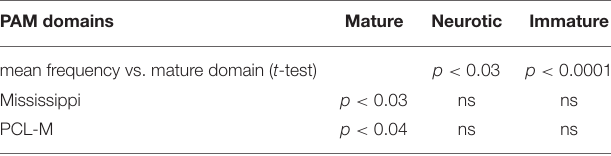
TABLE 2 | Mean difference and association probabilities ( n =